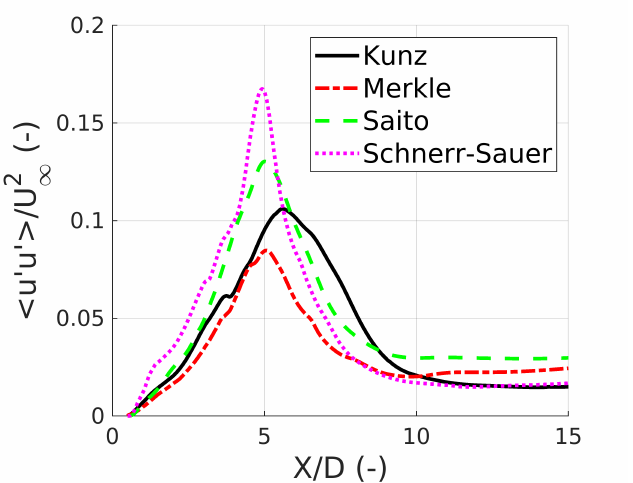
Figure 19. Variance of stream-wise velocity component downstream the cylinder along the centerline, with analytical-based